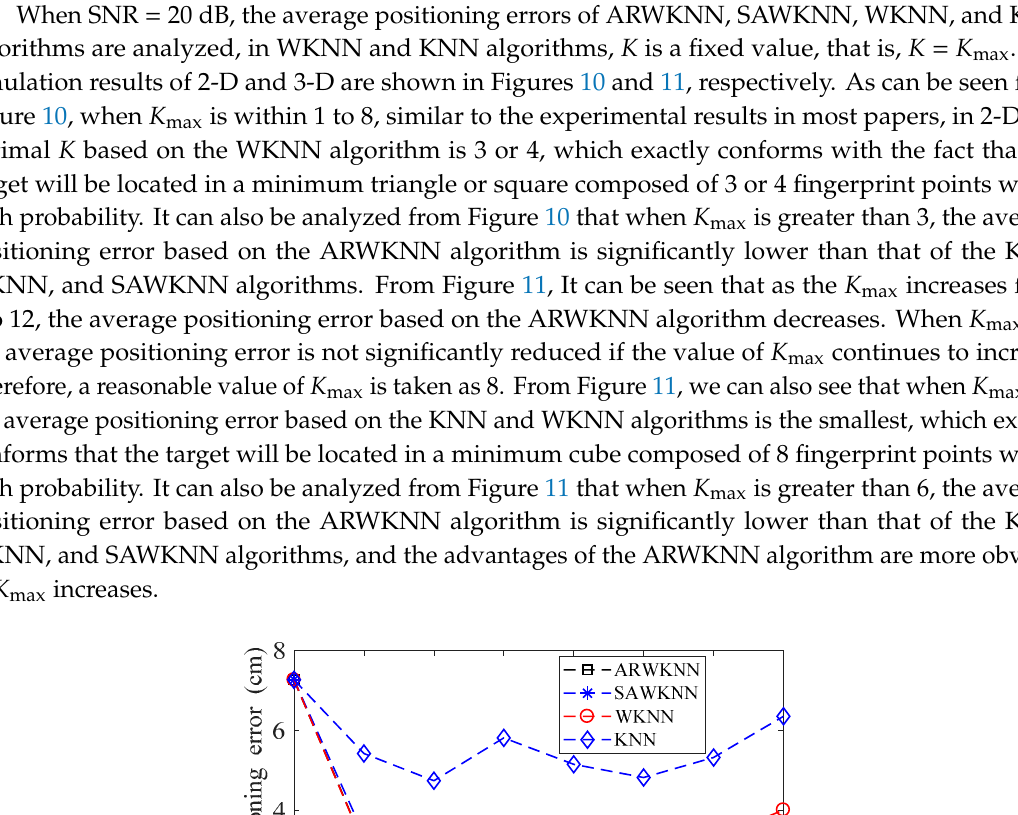
Figure 11. In 3-D, the impact of K max on the average positioning error. When SNR = 20 dB, the average positioning errors of ARWKNN, SAWKNN, WKNN, and KNN algorithms are analyzed with the variation of the fingerprint sampling point spacing S , the results of 2-D and 3-D are shown in Figures 12 and 13, respectively. It can be seen that as S decreases from 40 cm to 20 cm, whether in 2-D or 3-D, the average positioning error based on the ARWKNN algorithm is significantly lower than that of the KNN, WKNN, and SAWKNN algorithms, and the larger the S , the more obvious the advantage. As S decreases to 5 cm, the average positioning errors of four